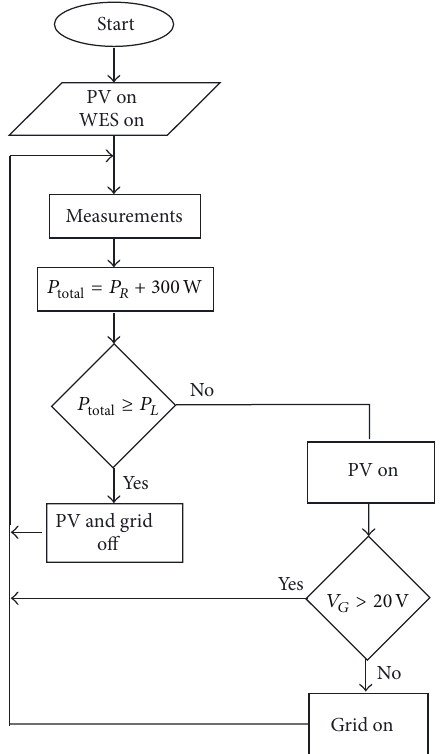
Figure 8: Simplified flow diagram of power management program.